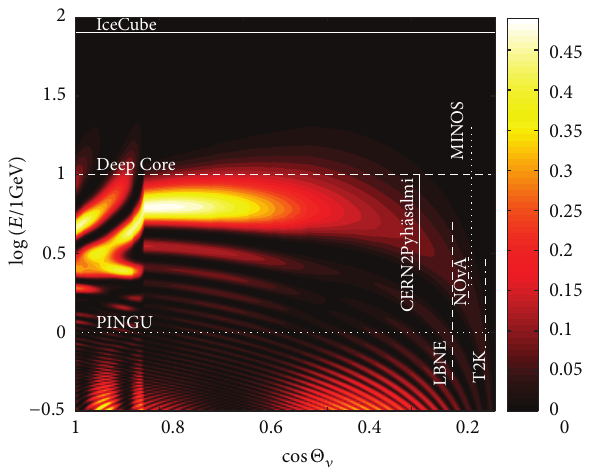
Figure 11: Physics reach of the accelerator and atmospheric neutrino experiments. Shown are areas in the oscillogram for ] 𝑒 → ] 𝜇 channel which can be covered by different accelerator (vertical sections) and atmospheric neutrino experiments (sensitive to the area above the corresponding horizontal